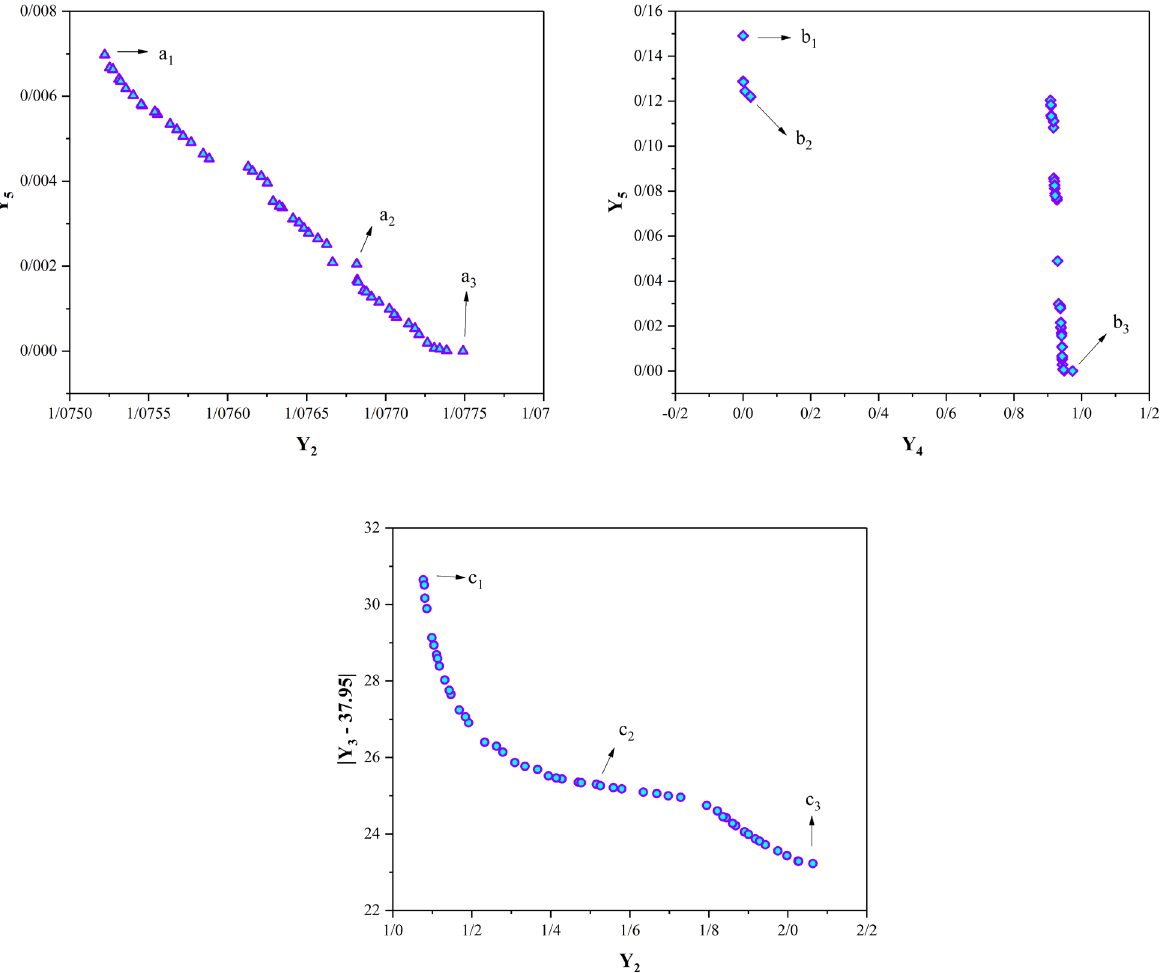
Figure 13: Pareto optimal front for (a) minimizing PSD (Y2) and b* (Y5), (b) minimizing a* (Y4) and b* (Y5), and (c) minimizing PSD (Y2) and obtaining L* (Y3) about